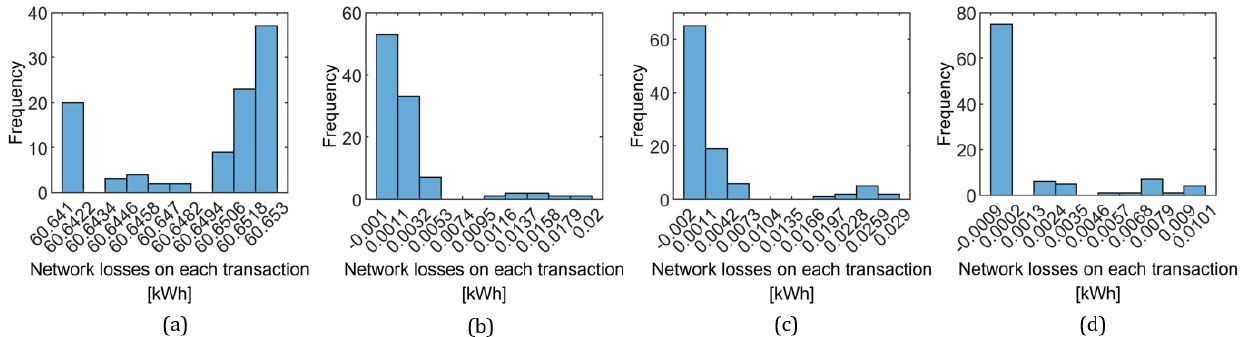
Figure 13. Histograms of network losses of selected transaction numbers in 100 trials of the guided case simulations with the IEEE 33 bus case and the transaction limit 5 kWh: ( a ) network losses of the #1 transactions in 100 trials; ( b ) network losses of the #200 transactions in 100 trials; ( c ) network losses of the #400 transactions in 100 trials; ( d ) network losses of the #600 transactions in 100 trials.